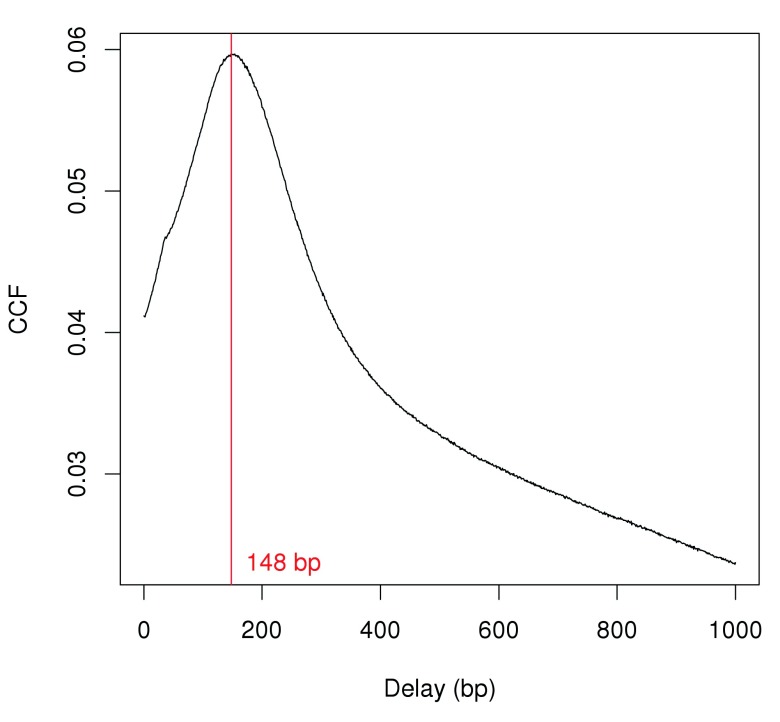
Cross-correlation function (CCF) against delay distance for the H3k9ac data set.The delay with the maximum correlation is shown as the red line.